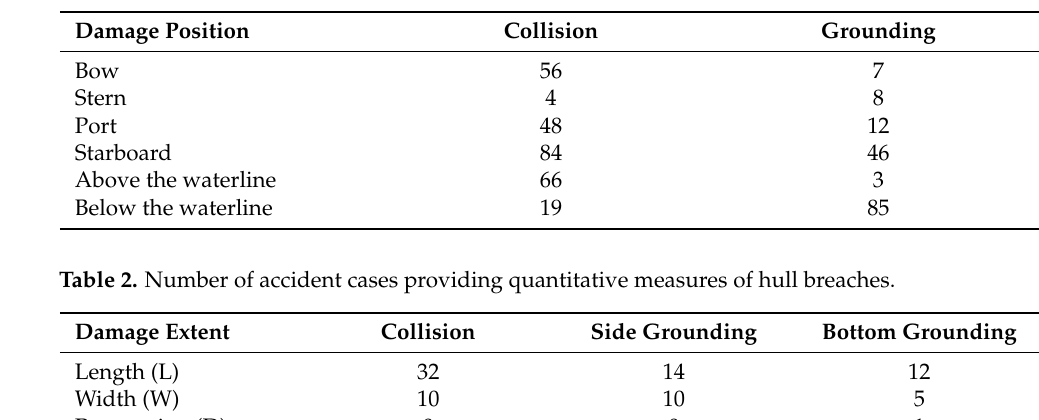
Table 1. Number of accident cases providing qualitative measures of hull damage positions.